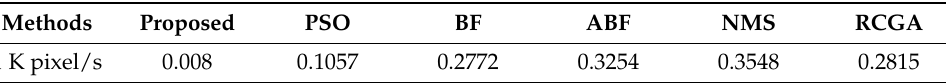
Table 5. Computation time compare with other